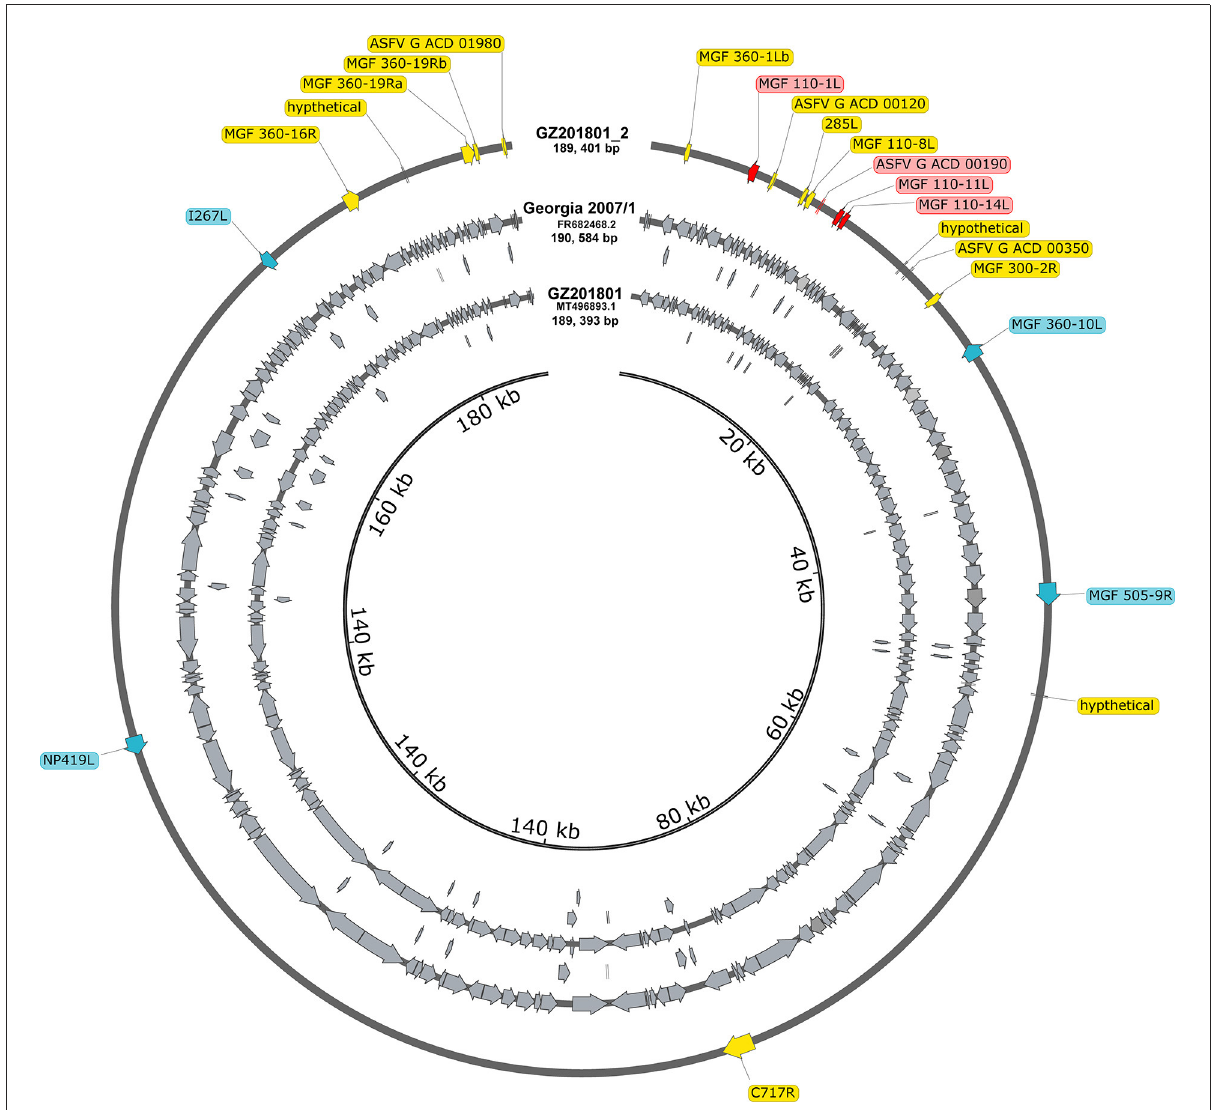
FIGURE2 All annotations in the entire genome of Georgia 2007/1 and GZ201801. Compared to GZ201801, the genes marked with yellow represent the updated annotation of the GZ201801_2. The genes in blue and red represent different annotations GZ201801_2 in Georgia 2007/1, where blue represents different annotations due to site mutations, and red represents different annotations that appear owing to deletion or early